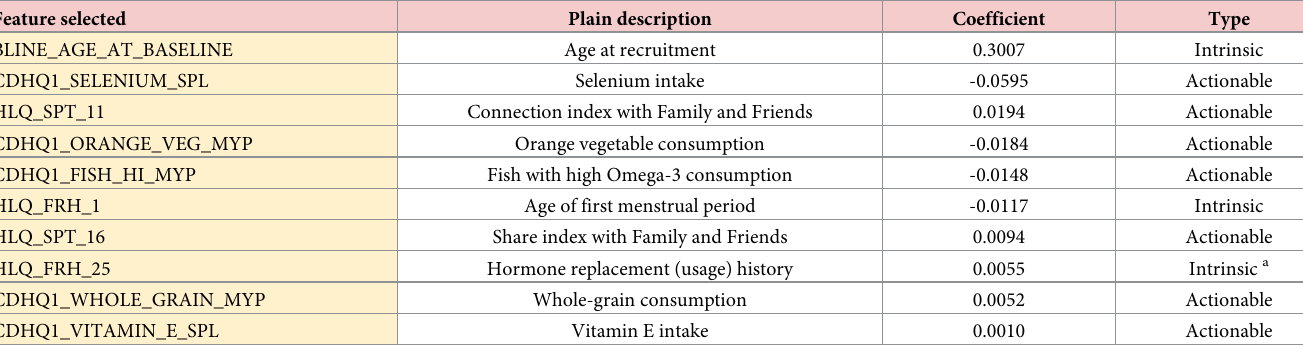
Table 3. Important features selected by multivariate Cox feature selection. Feature